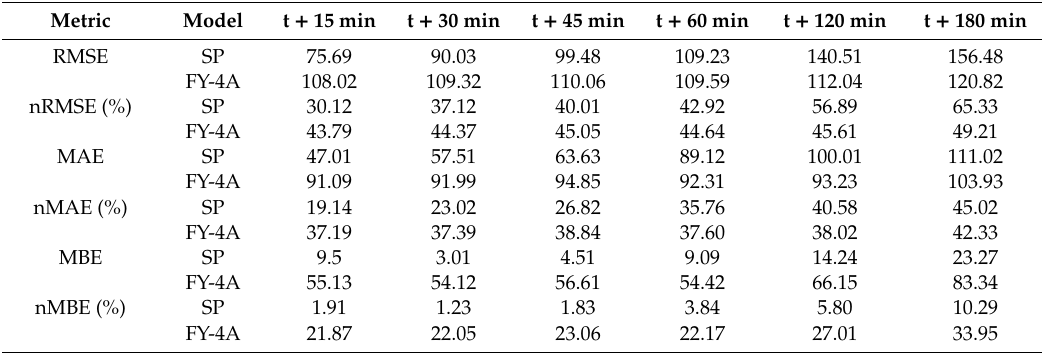
Figure 7. Forecasted results of GHI under snowy days with a 60 min horizon (14.11.2018, 16.11.2018, and 02.12.2018) for a total of 108 samples of the test set. Table 4. Statistical indexes for snowy skies with horizons from 15–180 min (in W / m 2 for the RMSE, MAE, and